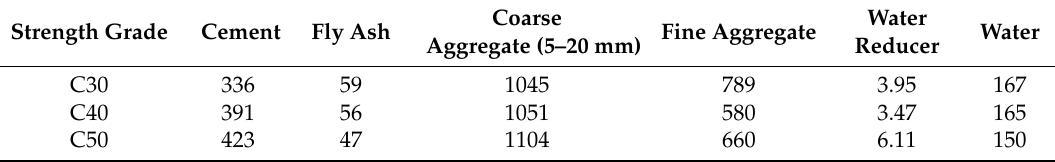
Table 1. C oncrete grade and mix proportion, kg/m 3 . Table 1. Concrete grade and mix proportion, kg/m 3 .